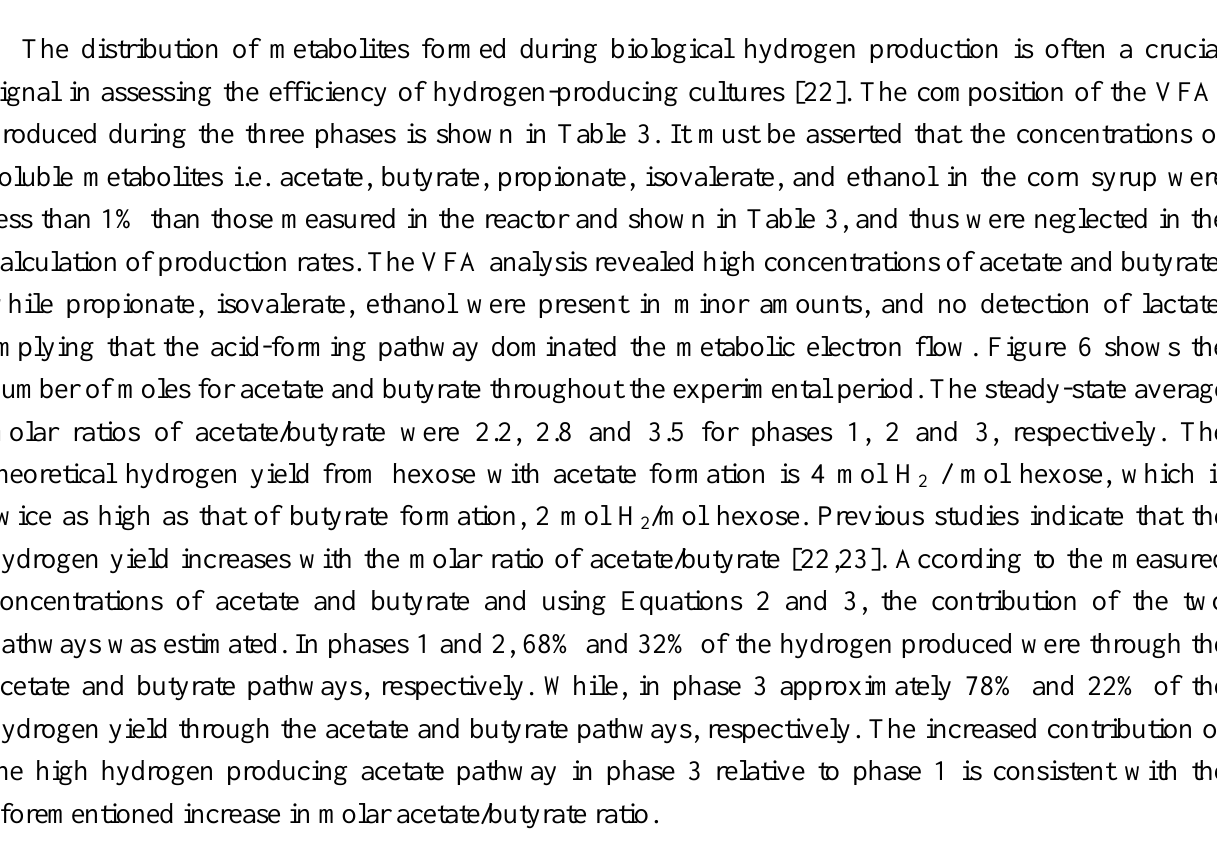
Figure 6. Temporal variation of molar acetate and butyrate